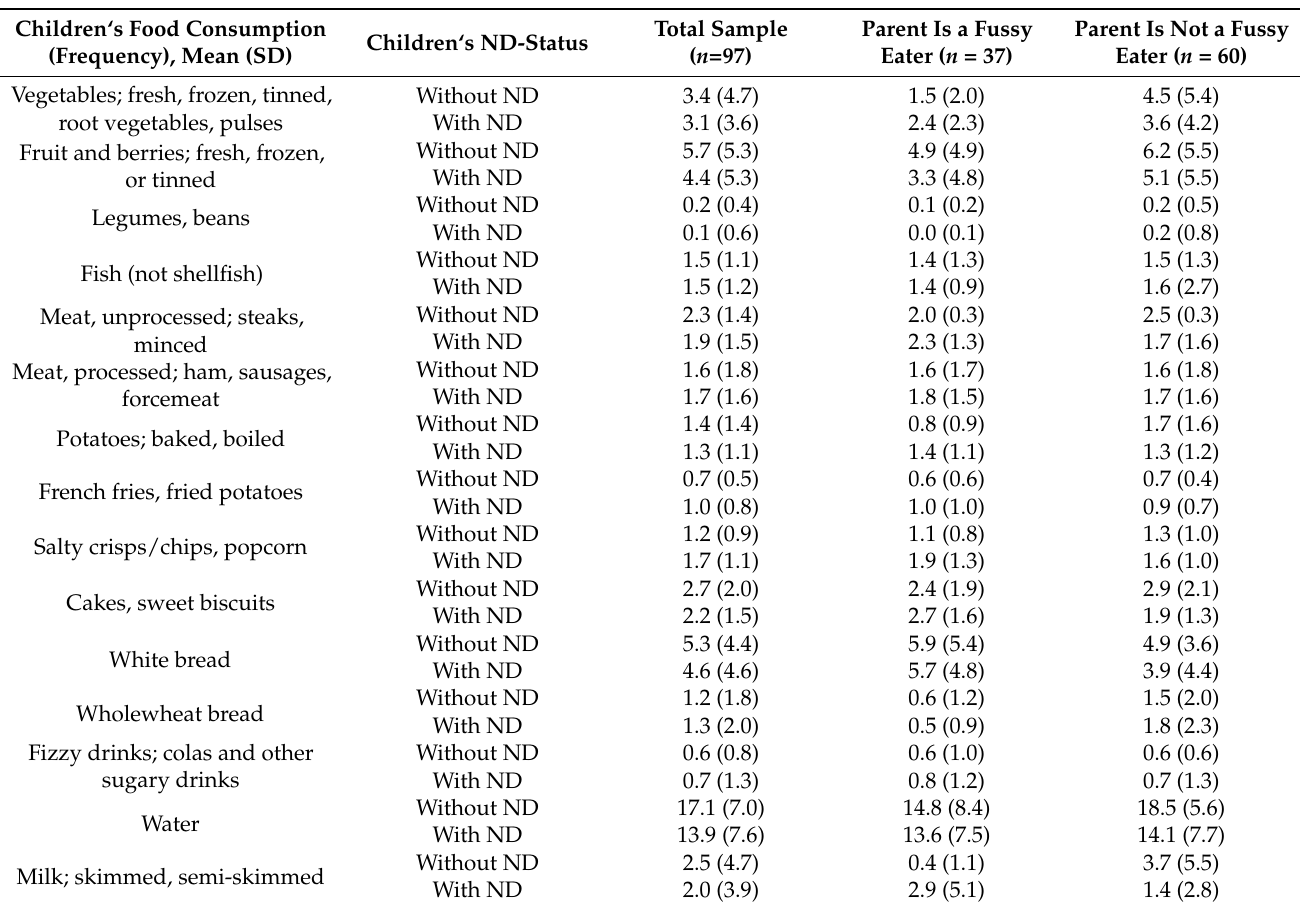
Table 4. Children’s mean food consumption (frequency) for various food items, based on children’s ND-status, and parents’ fussy eating status. Results are presented as Mean